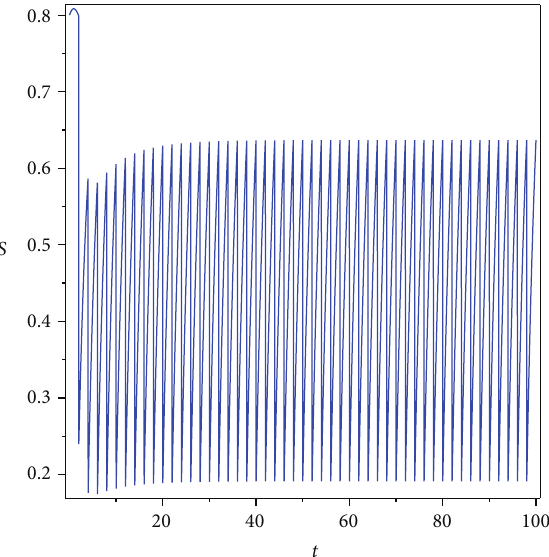
Figure 1: The relations of 𝑅 1 with the parameters 𝜃 and 𝑇 .